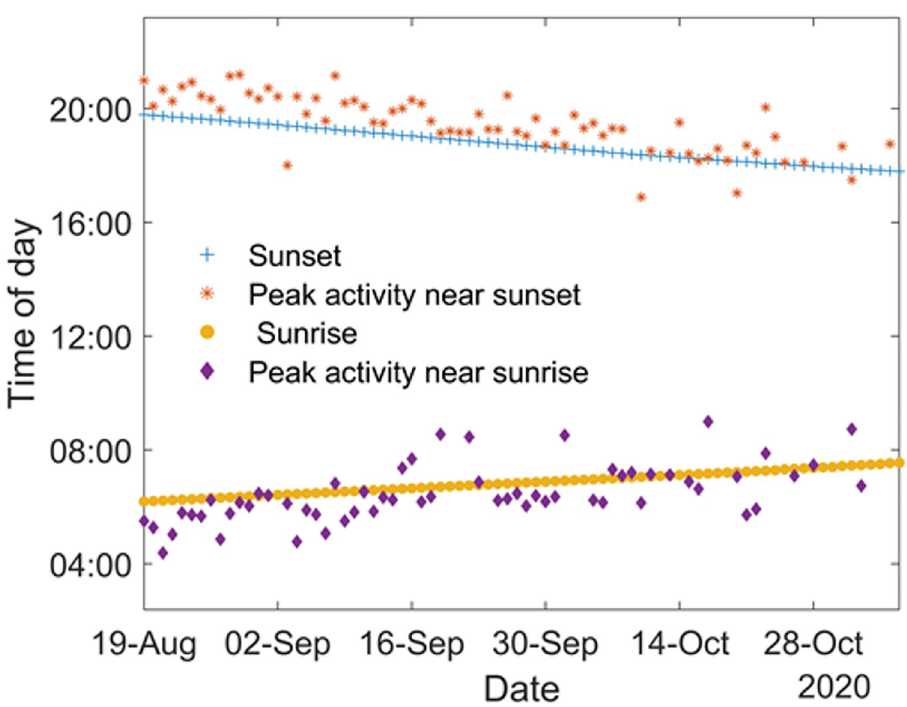
Fig 7. Peaks of mosquito activity (Cluster C4) near sunset (orange stars) and sunrise (purple diamond) in relation with the actual sunset (blue plus) and sunrise (yellow disk) time.